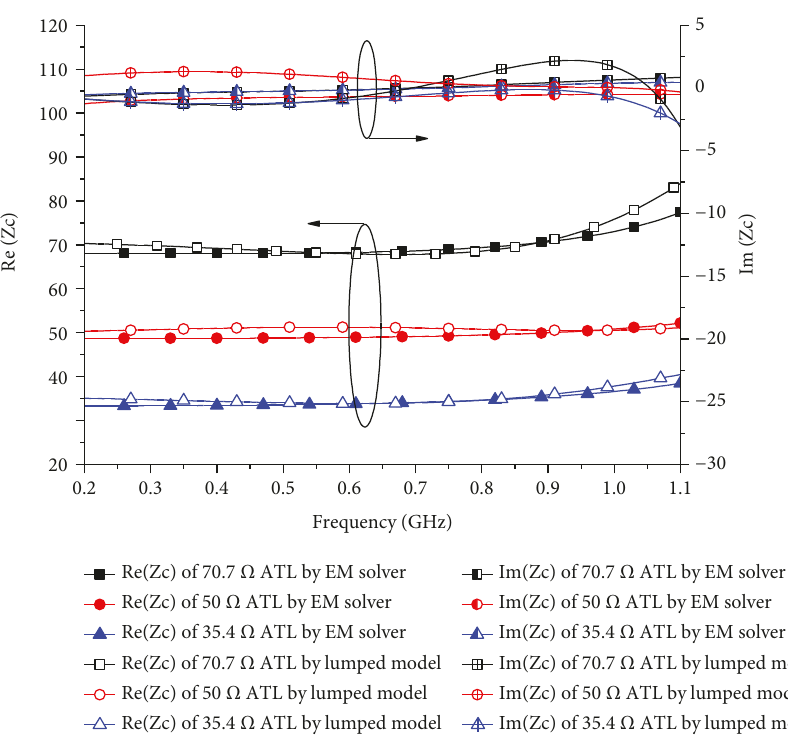
Figure 7: Simulated characteristic impedance of the proposed ATLs.